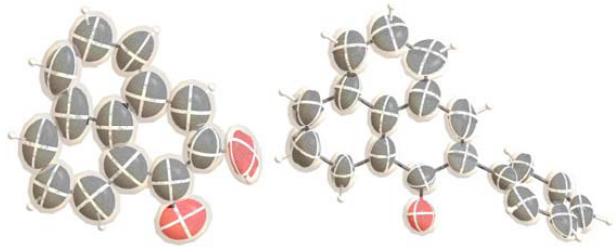
Figure 2. ORTEP diagram (50% probability) of isolated natural product ( left ) and synthetic product ( right ).